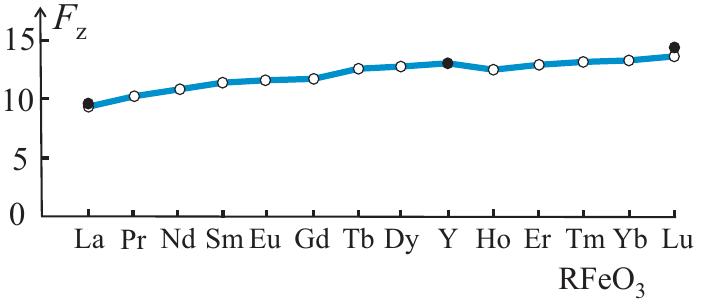
Figure 5. Theoretical predictions for the overt canting in orthoferrites (hollow circles) normalized on experimental data for YFeO 3 . Solid circles are latest experimental data for orthoferrites with nonmagnetic R